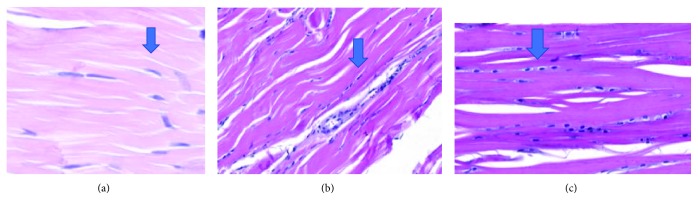
Enlarged images showing variations in the tenocytes, from linear and sparse to rounded and significantly increased.